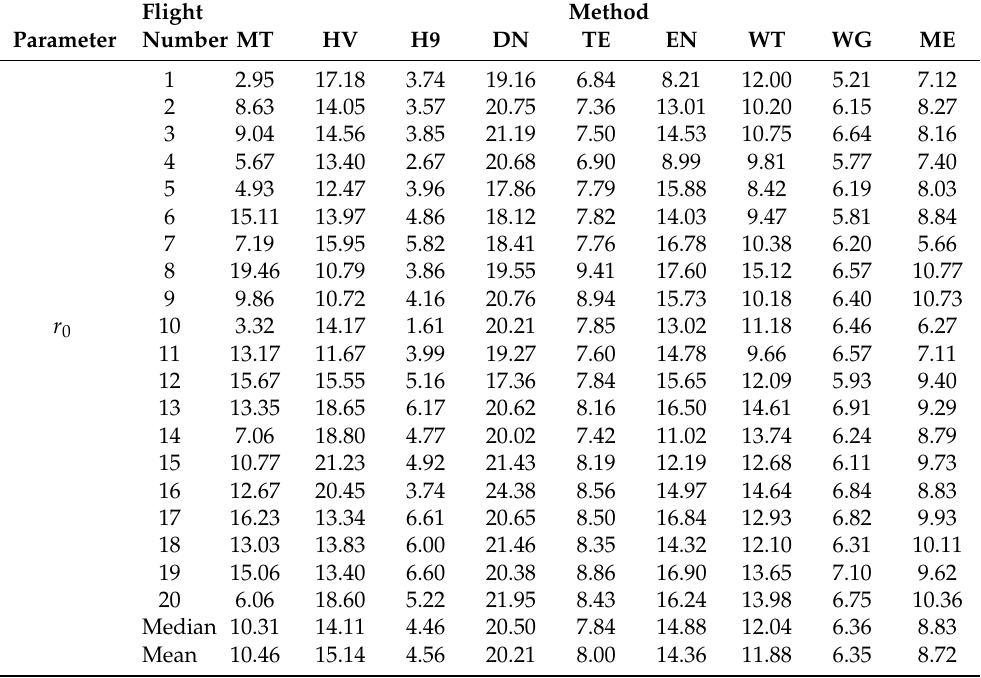
Table A7. NCACN integrated astronomical parameters details ( r 0 @ λ = 550 nm).